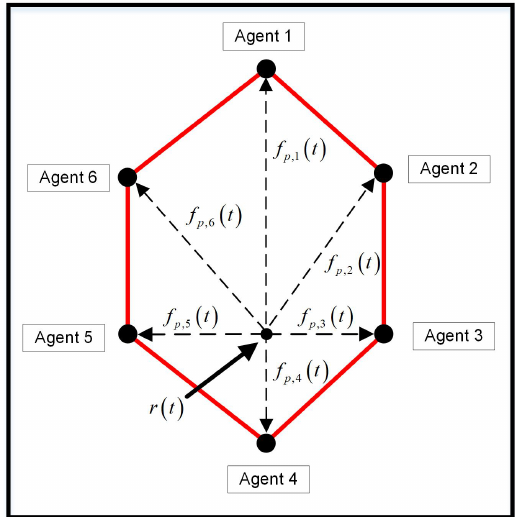
Figure 1. Formation shape of six